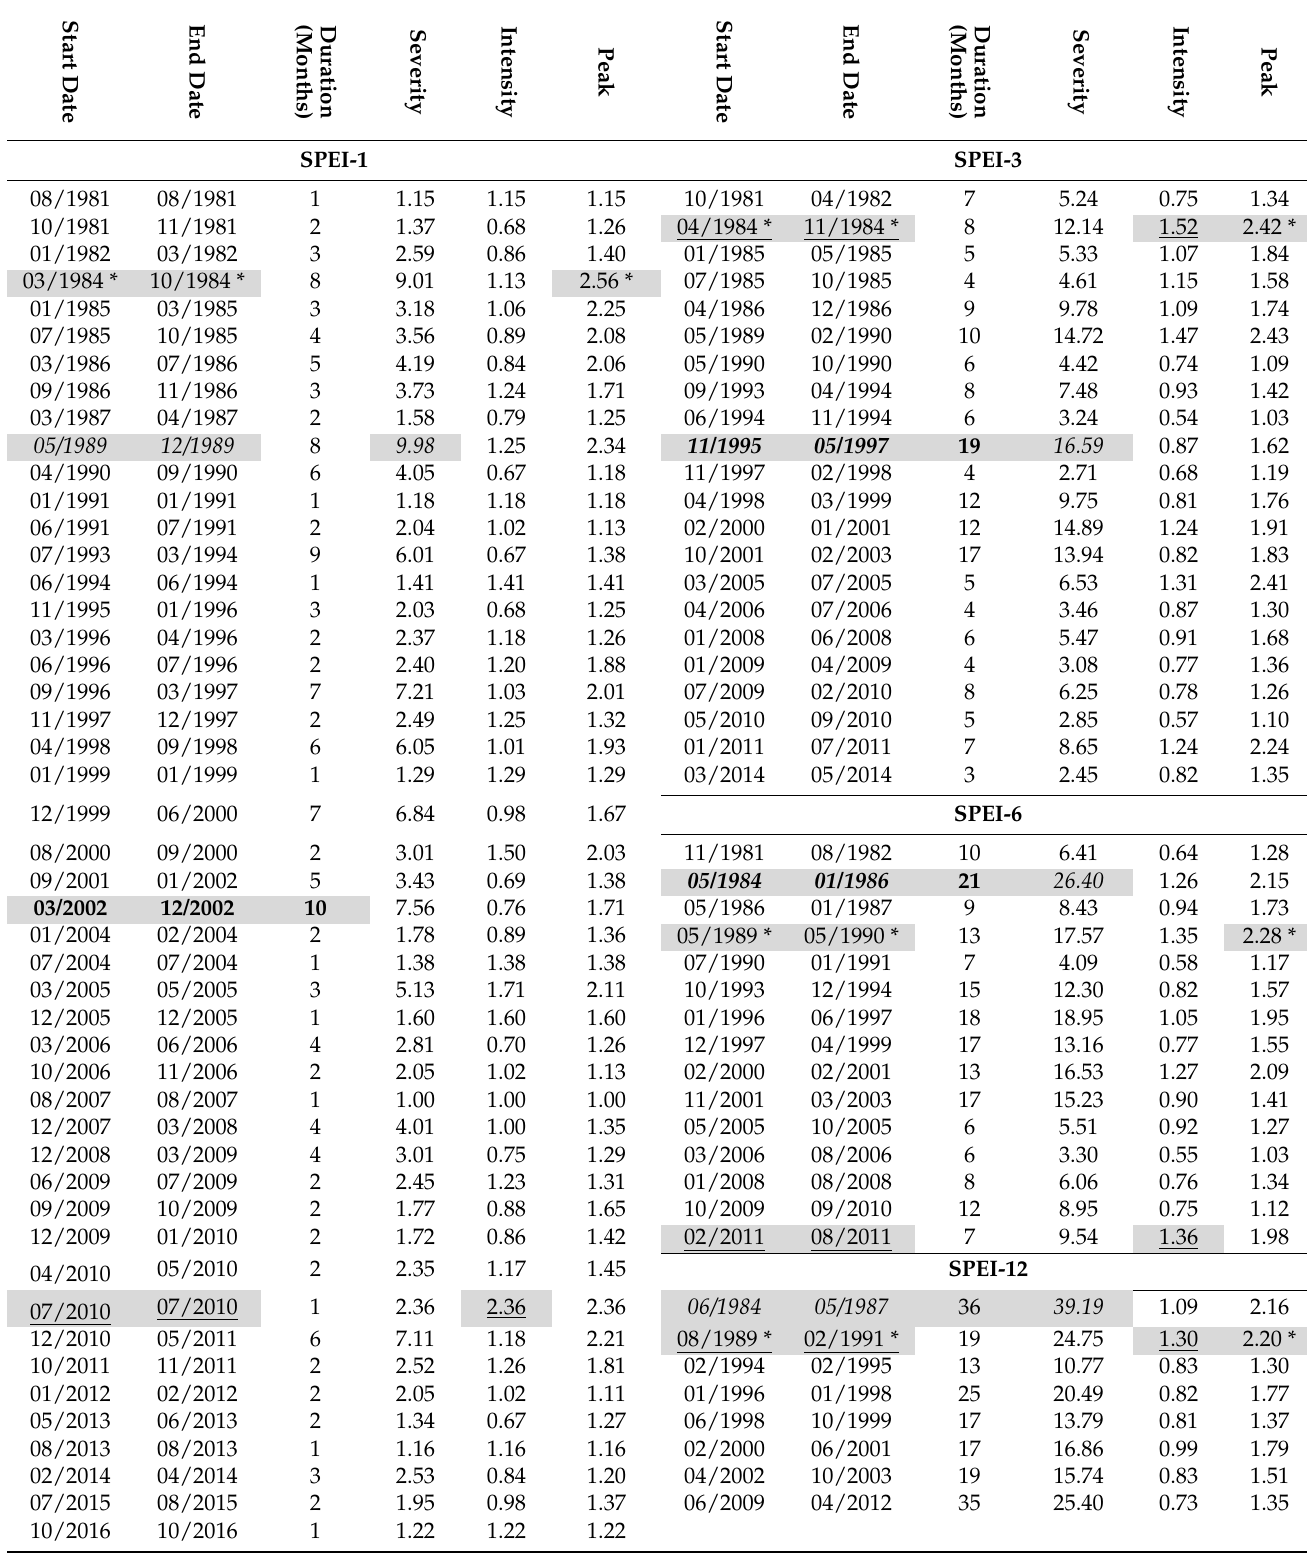
Table 3. The same as Table 2, but for wet events. For each scale, the events with a maximum in duration, severity, intensity, and peak are in gray and bold, italic, underline, and with